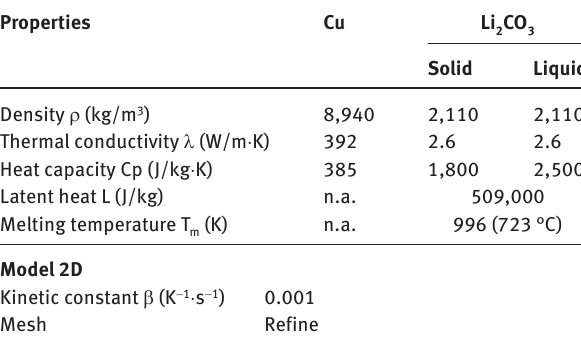
Table 3: Main characteristics used for the parametric study Properties